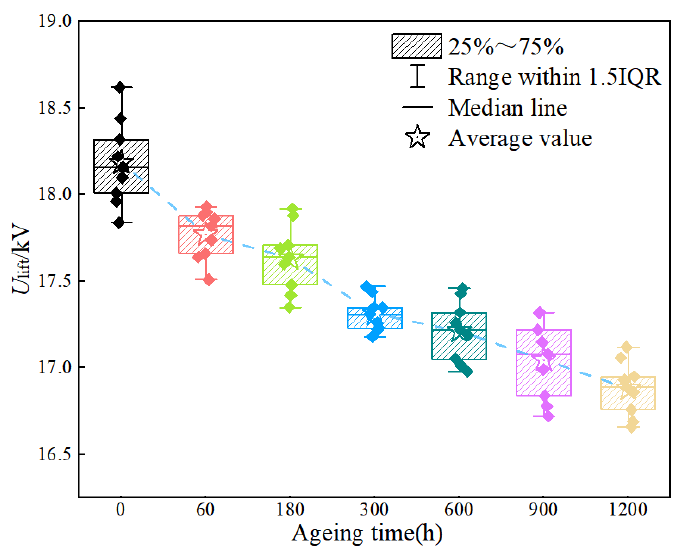
Figure 10. Lifting voltage of epoxy resin coating under different ageing